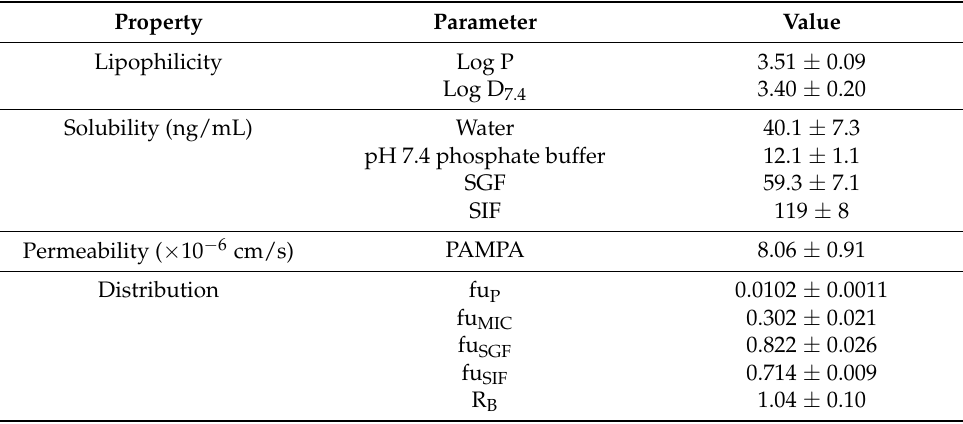
Table 2. Physicochemical properties of acacetin ( n =